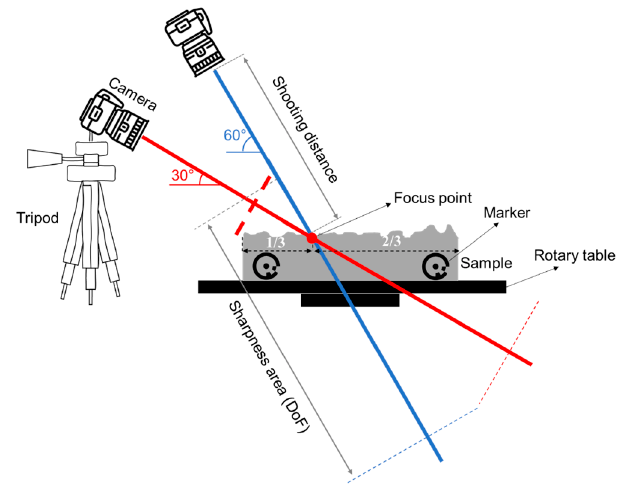
Figure 3. Sketch of the camera position in relation to the photographed sample. Table 3. Shooting distances measured during data capture.